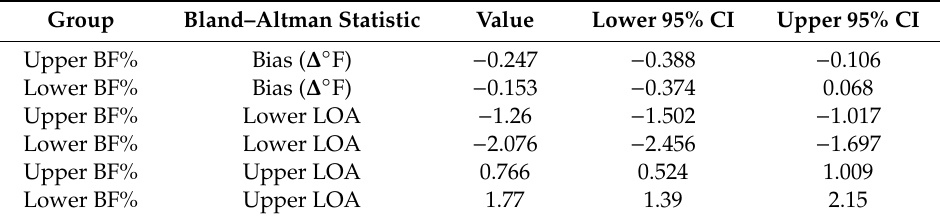
Table 5. Subgroup Bland–Altman statistics: Upper BF% and Lower BF%.